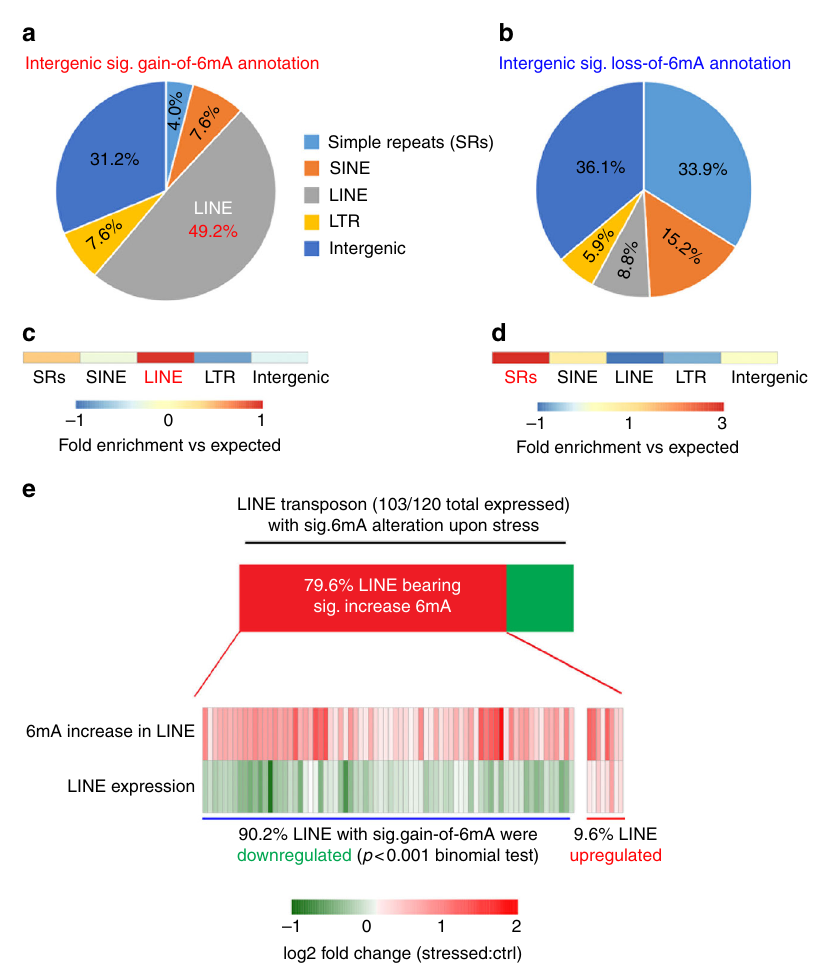
Fig. 3 Genome-wide 6mA pro fi ling in PFC reveals dynamic changes in 6mA on intergenic repetitive elements in response to stress. a , b Genomic annotation of signi fi cant gain- or loss-of-6mA demonstrate their percentage of repetitive elements association and enrichment vs. expected values. Stress- induced intergenic 6mA alterations occurred on distinct classes of repetitive elements. c , d The Log2 enrichment of annotated gain- or loss-of-6mA vs. expected values were calculated by HOMER annotation algorithm and demonstrated by heatmap. In total, 49.2% of intergenic gain-of-6mA occurred in the long interspersed nuclear element (LINE), which was highly enriched over expected. Loss-of-6mA was predominantly enriched in simple repeats over expected values. e Gain-of-6mA on intergenic regions correlated with downregulation of LINE transposon expression. In total, 79.6% of dynamic 6mA marked LINE transposons possessed gain-of-6mA, with 90.4% of these LINE expression being downregulated upon stress. P < 0.001, Chi-squared test comparing to short interspersed nuclear element (SINE) transposon. The fold changes (Stressed:Control) of both 6mA and LINE expression are indicated by Heatmap. Red plots (Log2 fold change > 0) indicate increased expression upon stress (stressed > control), whereas green plots (fold change < 0) indicate decreased expression upon stress (stressed <